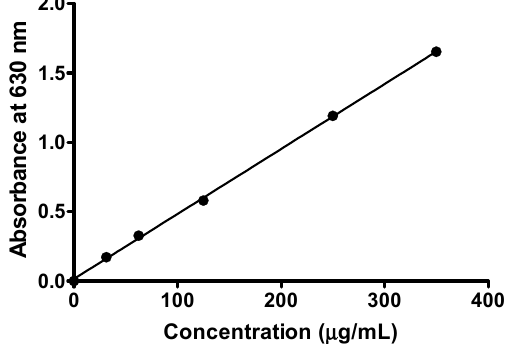
Figure 12. The standard curve of ferric ion antioxidant power (FRAP) was obtained using 0–350 µ g/mL of ascorbic acid at absorbance of 630 nm.